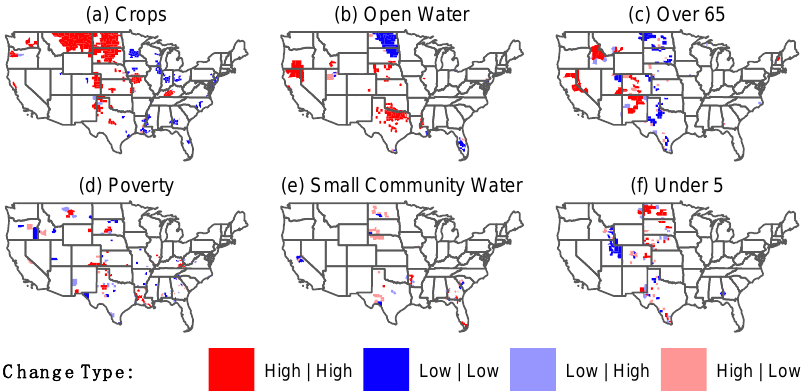
Figure 3. Results of Local Moran’s I analysis for the changes in vulnerability variables over the study periods. The six figures show changes in vulnerability over the two study periods (2010–2014 to 2015–2019). Dark red indicates the clustered increase and dark blue indicates a clustered decrease. Light red and light blue indicate high outliers and low outliers, respectively.